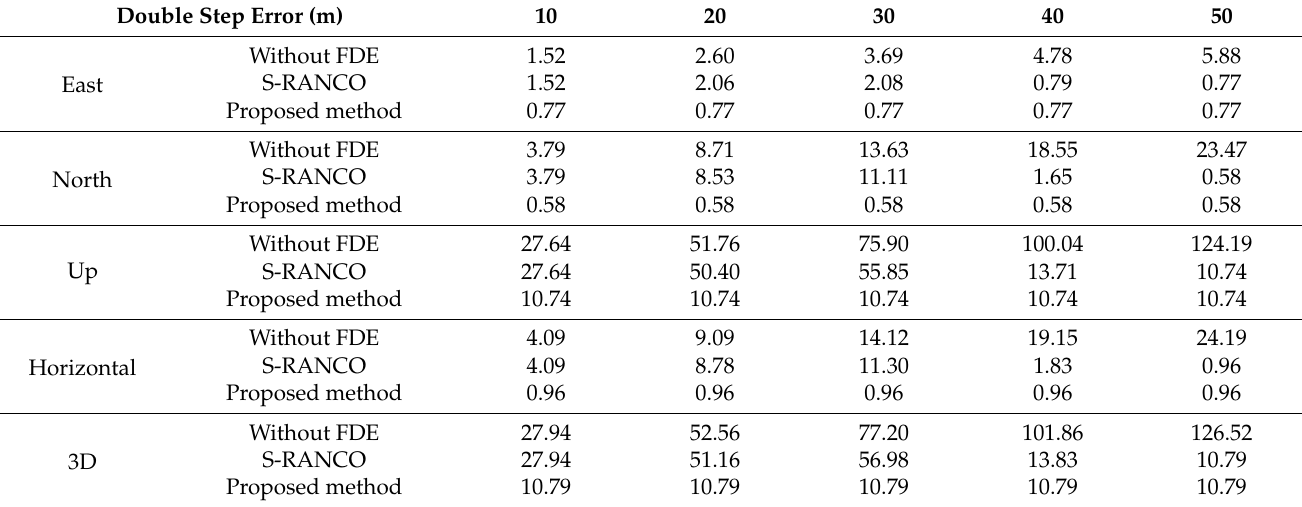
Table 9. The RMSE (m) of positioning results for Scenario